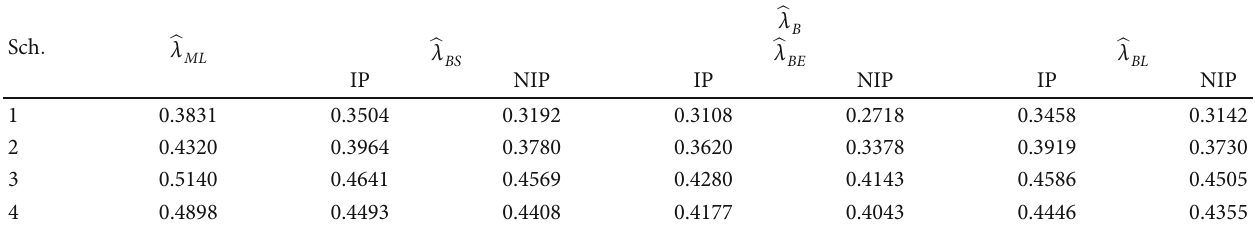
Table 7: The ML and Bayesian estimates of λ based on the di ff erent Type-II uni fi ed PHCSs from real data. Sch :